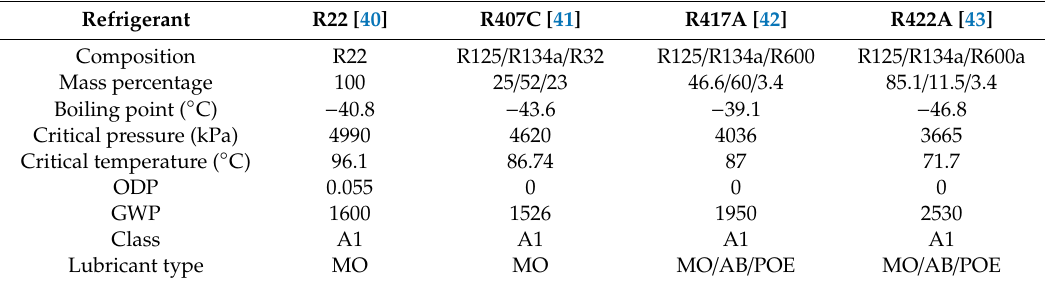
Table 2. Properties of R422D, R424A, R427A, and Figure 6. Top refrigerants in food industry [9].